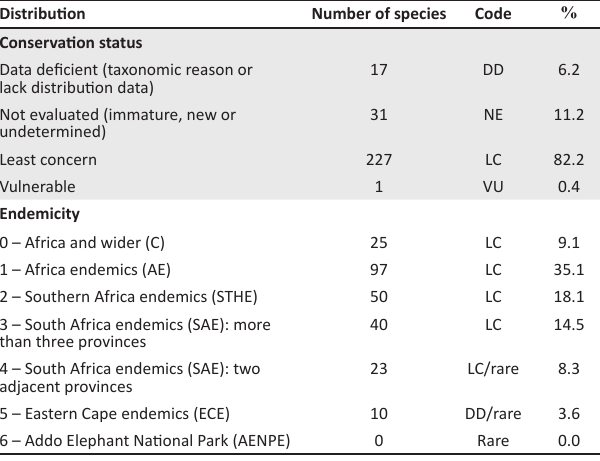
TABLE 3: Species of special concern recorded from the Addo Elephant National